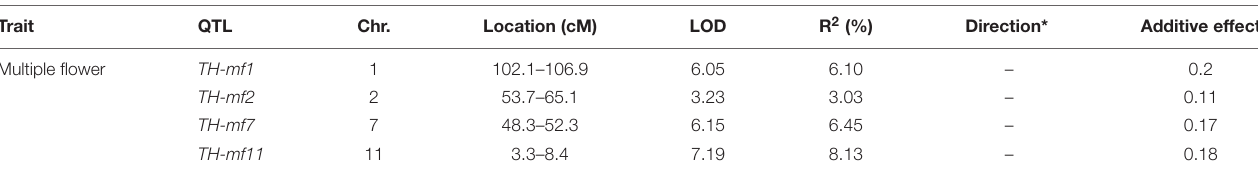
FIGURE 3 | Genome-wide QTL plot associated with the multiple-flowers-per-node trait detected in the TH RIL population. The red horizontal line indicates a LOD score threshold of 3.2. Small black bars above the X -axis indicate the detected QTLs. TABLE 3 | Quantitative trait locis controlling the multiple-flowers-per-node trait detected across TH RILs.